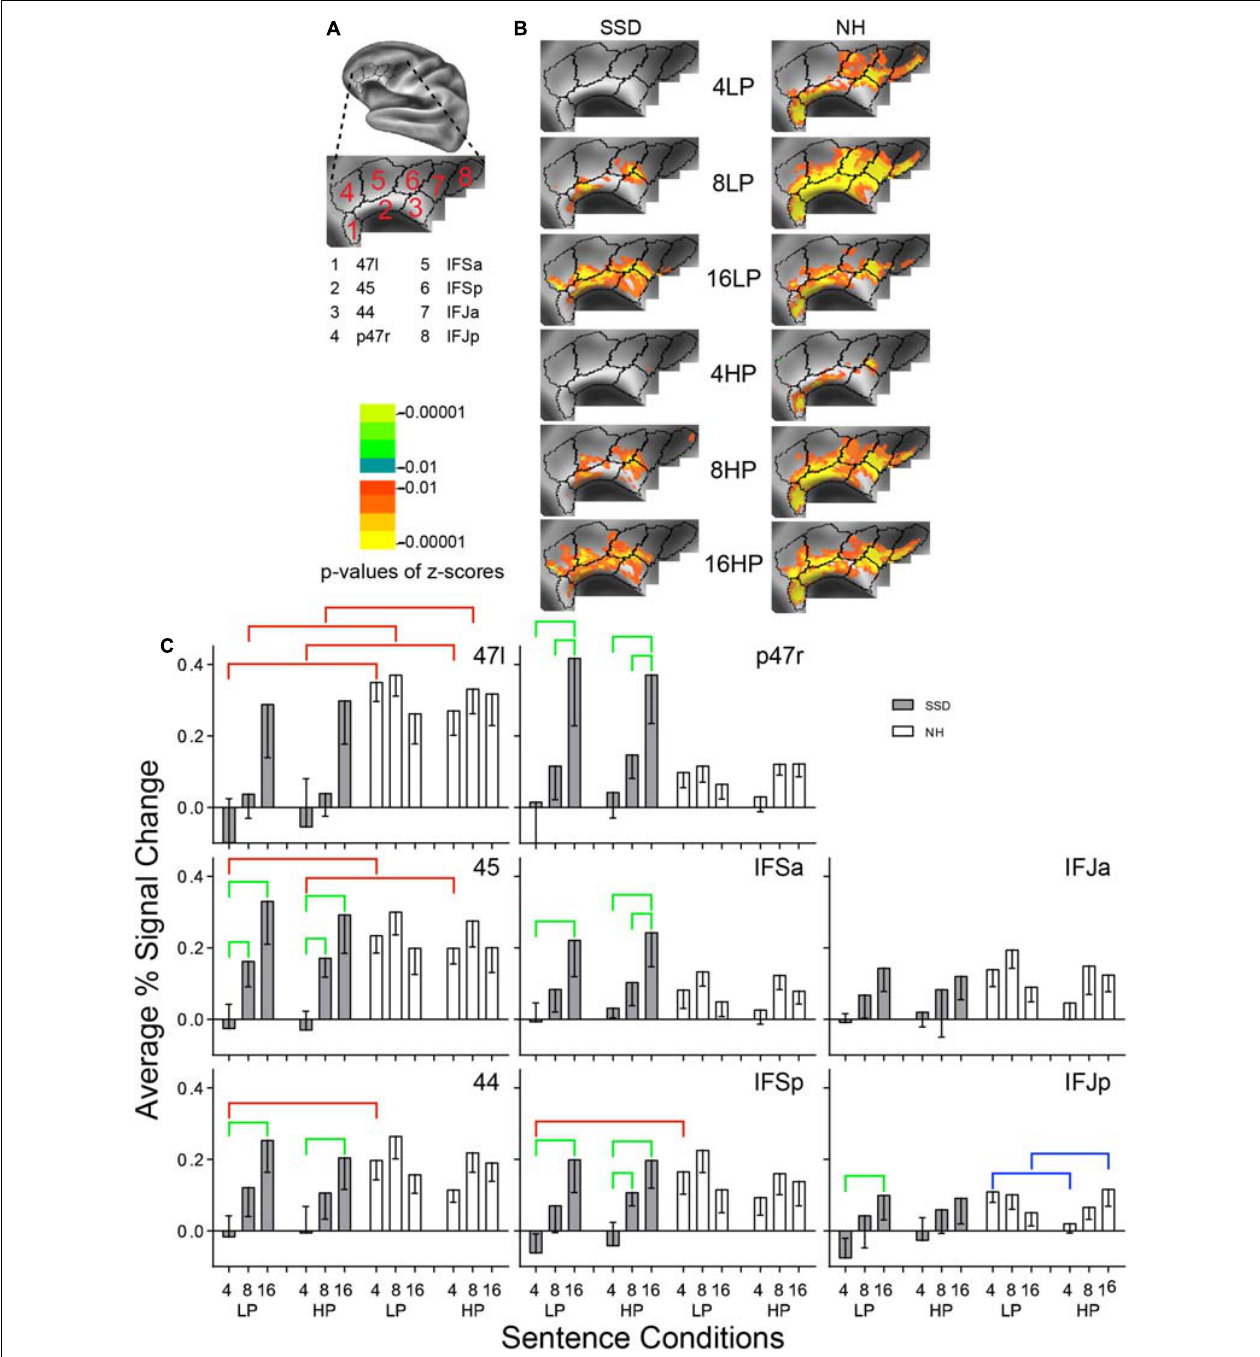
FIGURE 5 | Results from eight parcels in the LH Inferior Frontal Cortex (IFC) region. (A) Lateral view of a partially inflated hemisphere rotated superior and tilted slightly medial. (B) Enlarged views of parcels with clusters scaled as in Figure 3 . (C) 47l, 45, 44, and IFSp had significant group effects marked with red brackets. 45, 44, p47r, IFSa, IFSp, and IFJp had significant intelligibility effects marked with green brackets. IFJp had a significant predictability effect marked by a blue bracket.